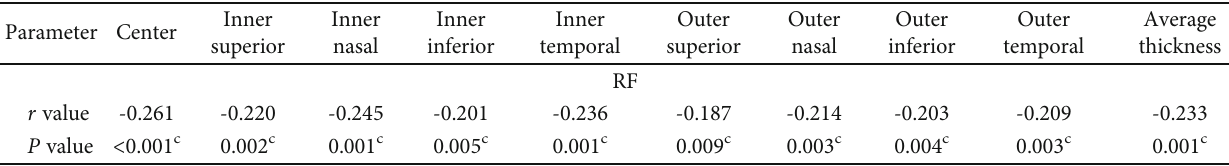
Table 5: The relationship of serum RF with choroidal